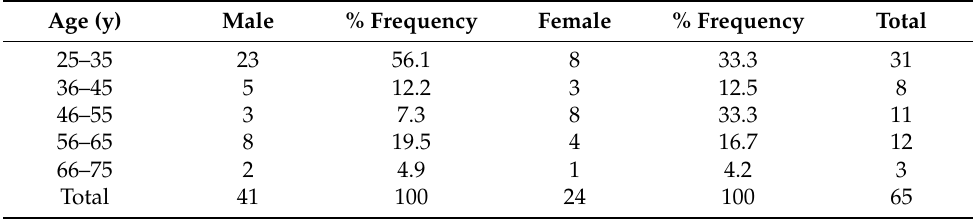
Table 1. Distribution of the interviewees according to the age group and the